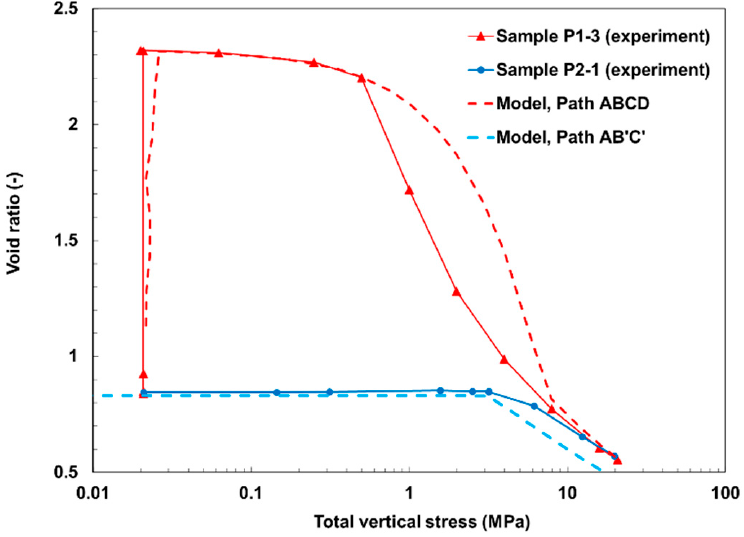
Figure 12. The evolution of void ratio during saturation and subsequent compression steps: experi- mental (data from [37] (CC BY 4.0)) and modeling results.